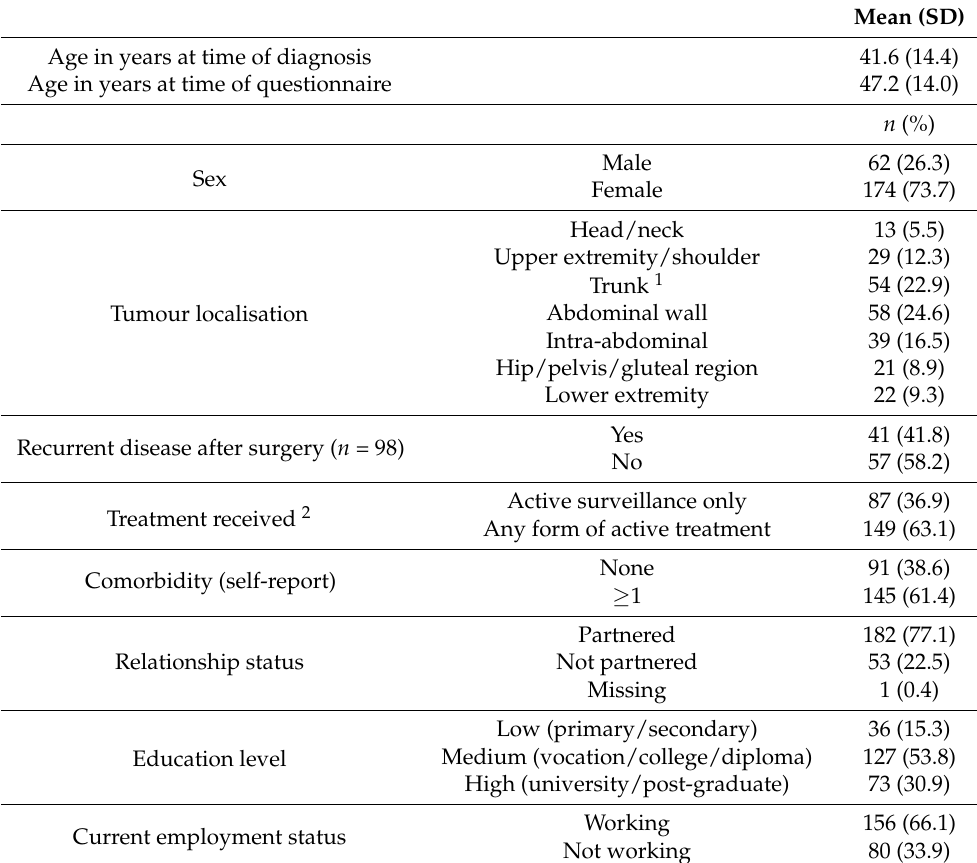
Table 1. Desmoid-type fibromatosis patient characteristics ( n =